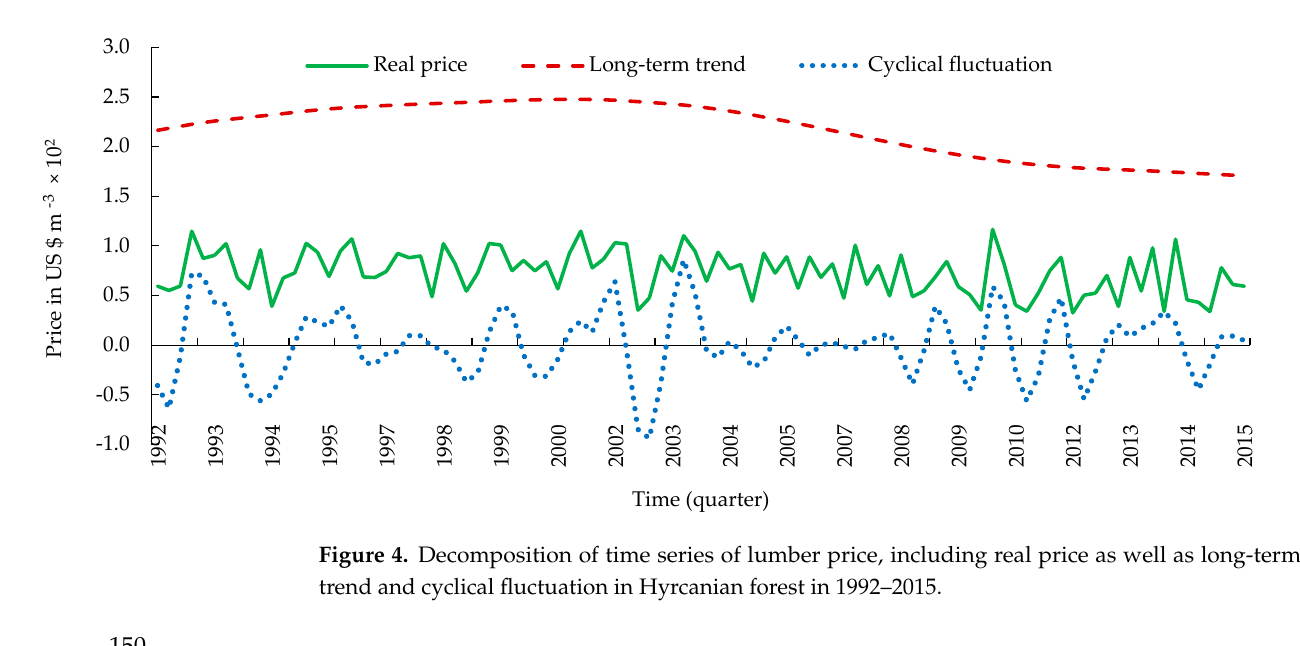
Table 5. Results of F-test for the seasonality in high-value species of sawlog price (price in 100 US $ m − 3 ).